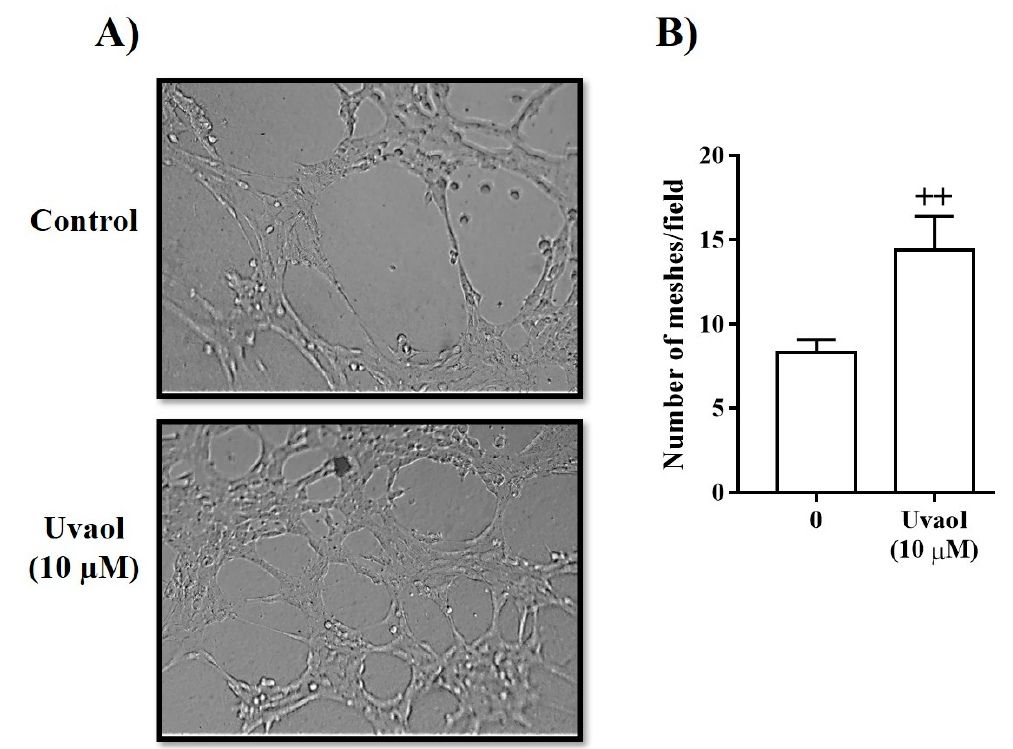
Figure 5. Effect of uvaol on the formation of the tubular network in endothelial cells on Matrigel after 16 h. ( A ) Representative images of tubule-like structures on Matrigel by endothelial cells following 16 h of treatment. The tubes were photographed under the microscope at 200× magnification. ( B ) Analysis of the number of meshes formed after medium or uvaol treatment. Bars represent mean ± SD of three independent experiments. Statistical significance between groups was determined by Student’s test. (++) p < 0.01 compared with medium-treated cells after 16 h.